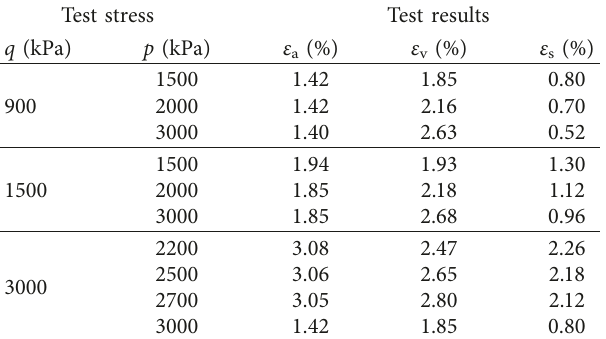
Figure 4: q versus ε s curve(stressconditionsofequal p andunequal q Table 3: Test stress conditions and test results (stress conditions of equal q and unequal p ).